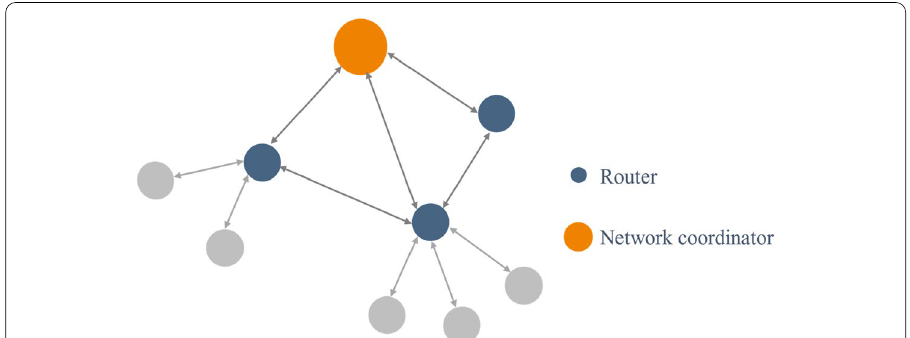
Fig. 3 Zigbee mesh network topology